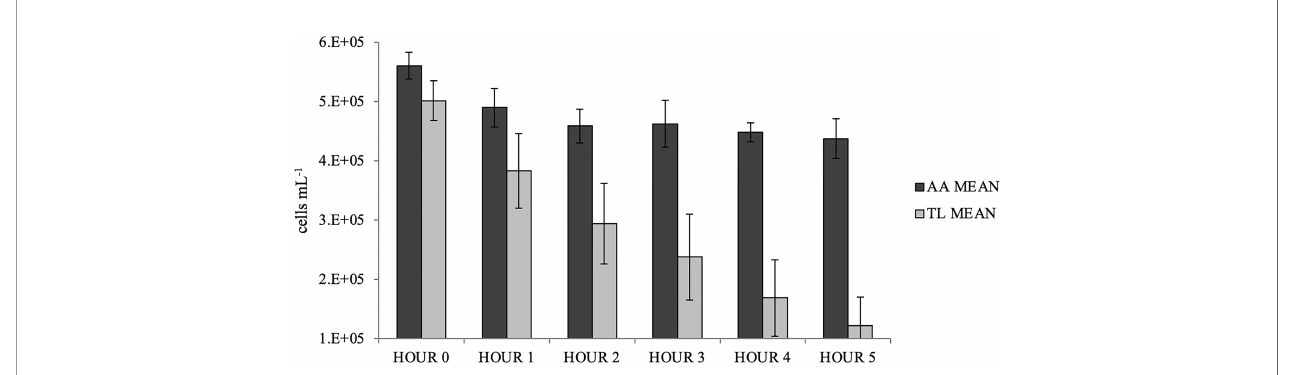
FIGURE 4 | Mean (± s.d., n=10) hourly microalgae cell densities for Styela plicata exposed to Aureococcus anophagefferens (AA) or Tisochrysis lutea (TL,